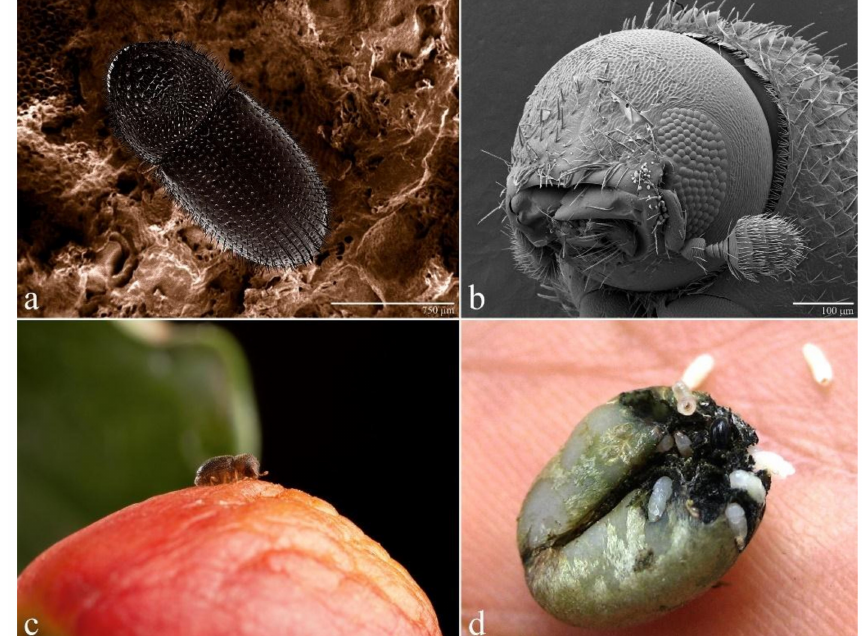
Figure 1. Dorsal view ( a ) and detail ( b ) of an adult female coffee berry borer. Female adult on a coffee berry ( c ). Damage caused by larval feeding on the coffee bean ( d ). Photos by Eric Erbe (a; USDA-ARS); Gary Bauchan (b; USDA-ARS); Peggy Greb (c; USDA-ARS); and Francisco Infante (d; El Colegio de la Frontera Sur,